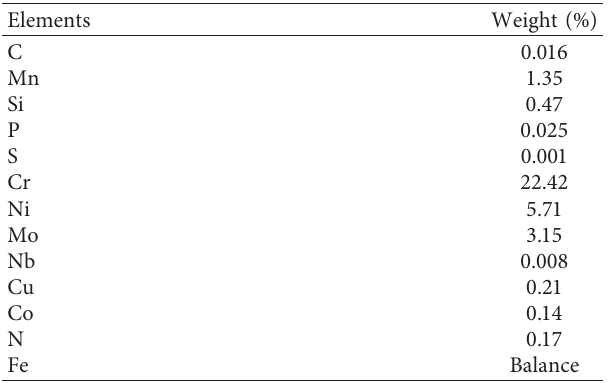
Table 1: Chemical composition of duplex stainless steel grade 2205.